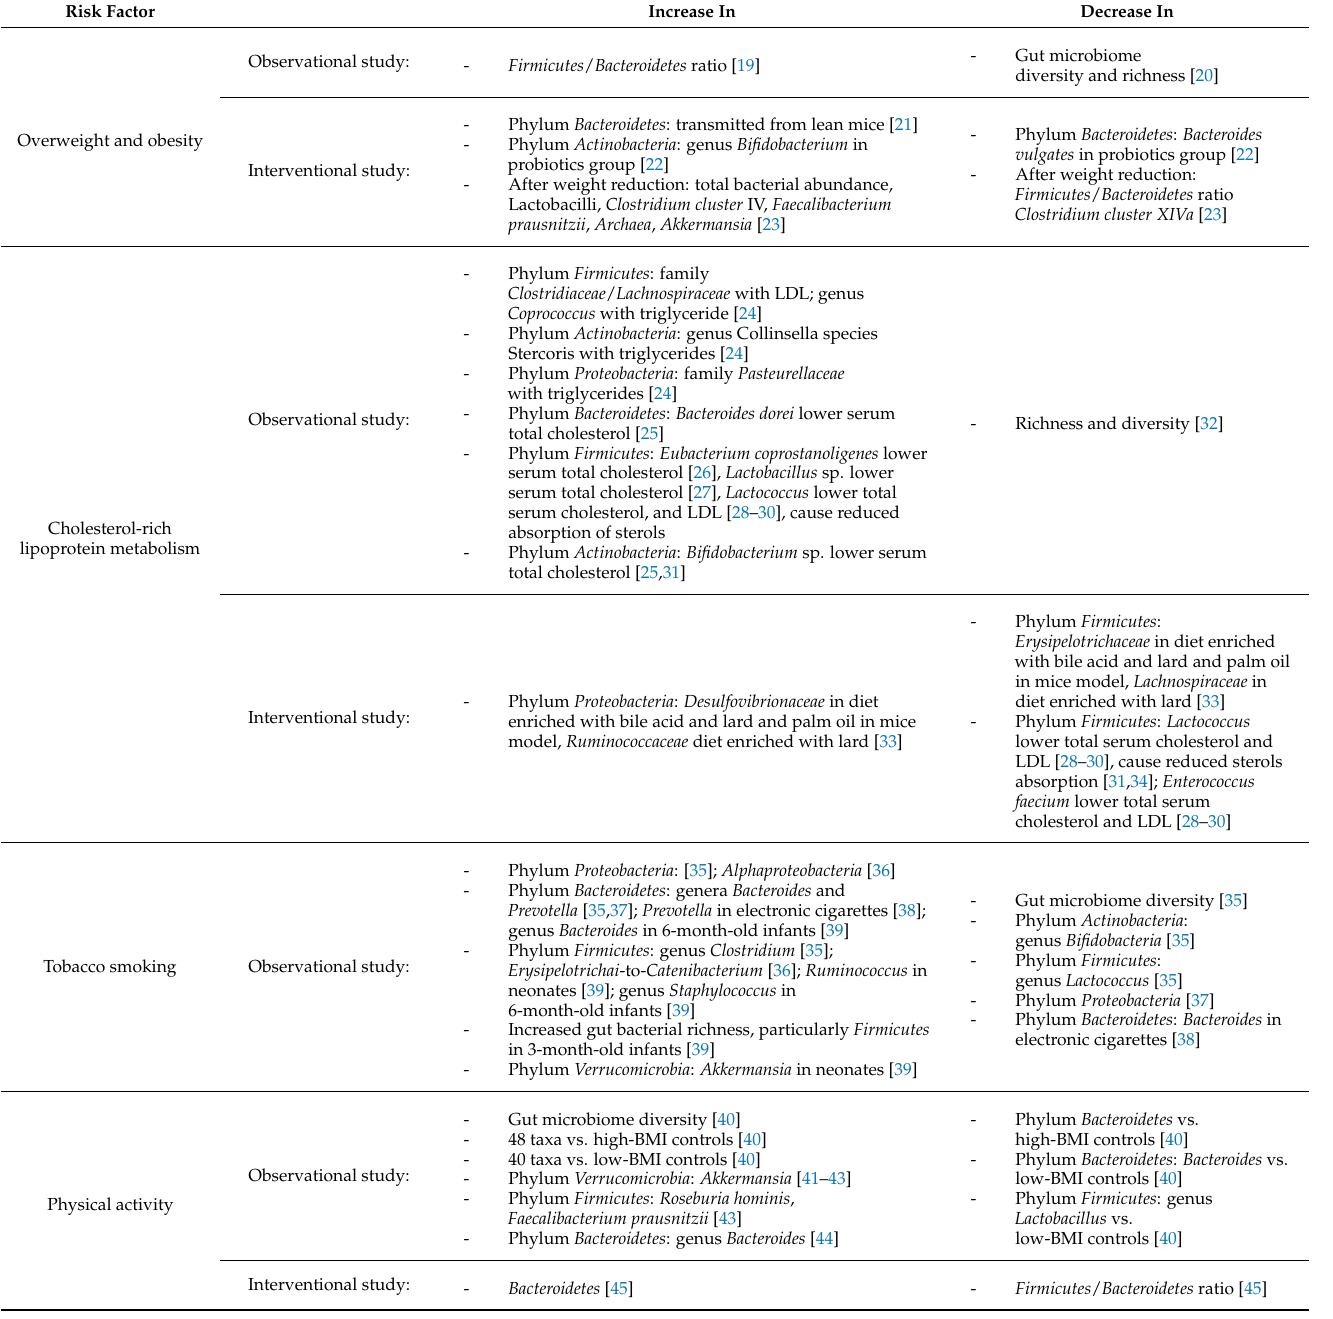
Table 1. Association of microbiome with modifiable risk